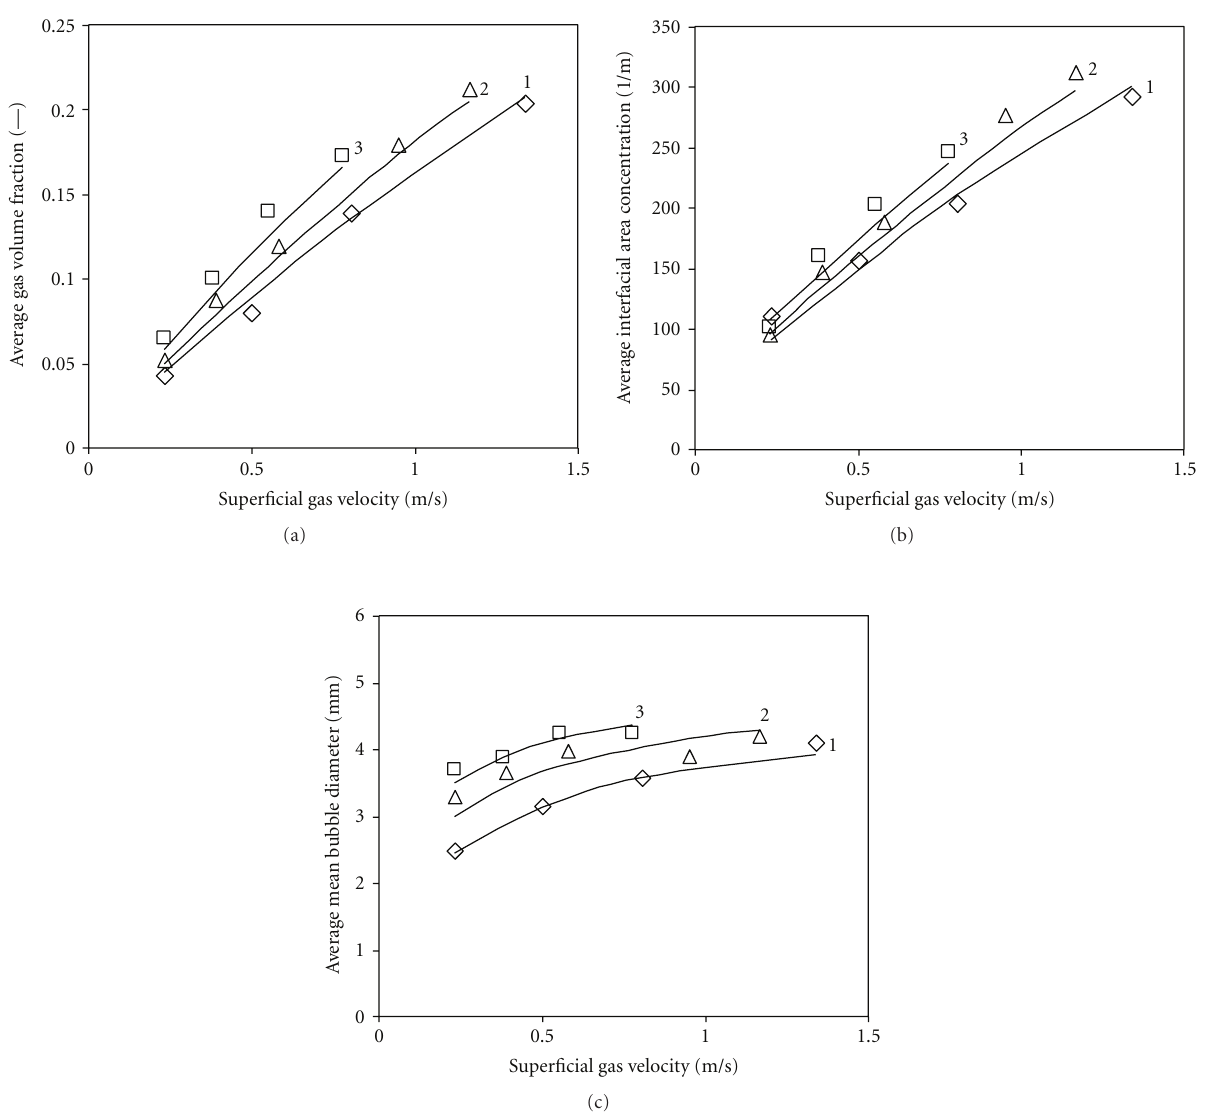
These correspond, respectively, to the monosized bubbles of 1.45 mm (Figure 11(a)), 9.55 mm (Figure 11(c)), and